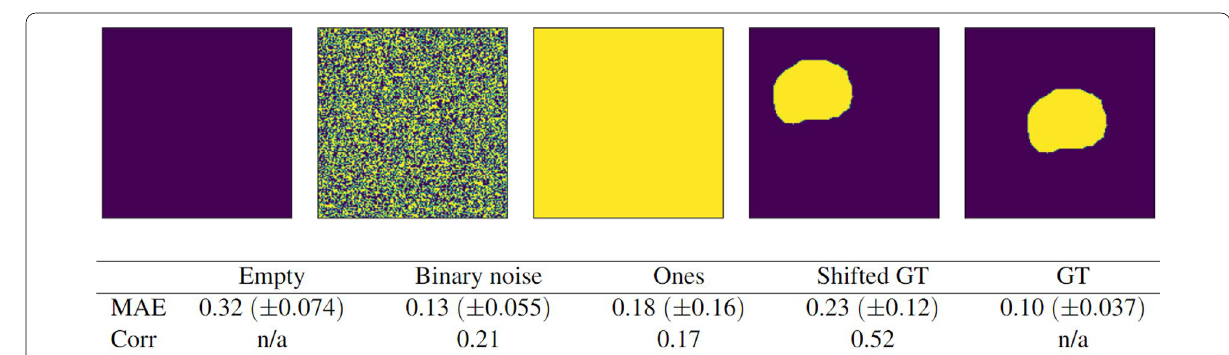
Fig. 7 Performance of the quality prediction model (MAE and rank correlation of predicted Dice scores) on different cases of failed segmentations: completely empty contours, pure noise, matrices full of ones, and shifted ground truths (GTs). The performance on real GT segmentation maps is also shown. All results are aggregated over 5 different validation splits for a total of 80 samples